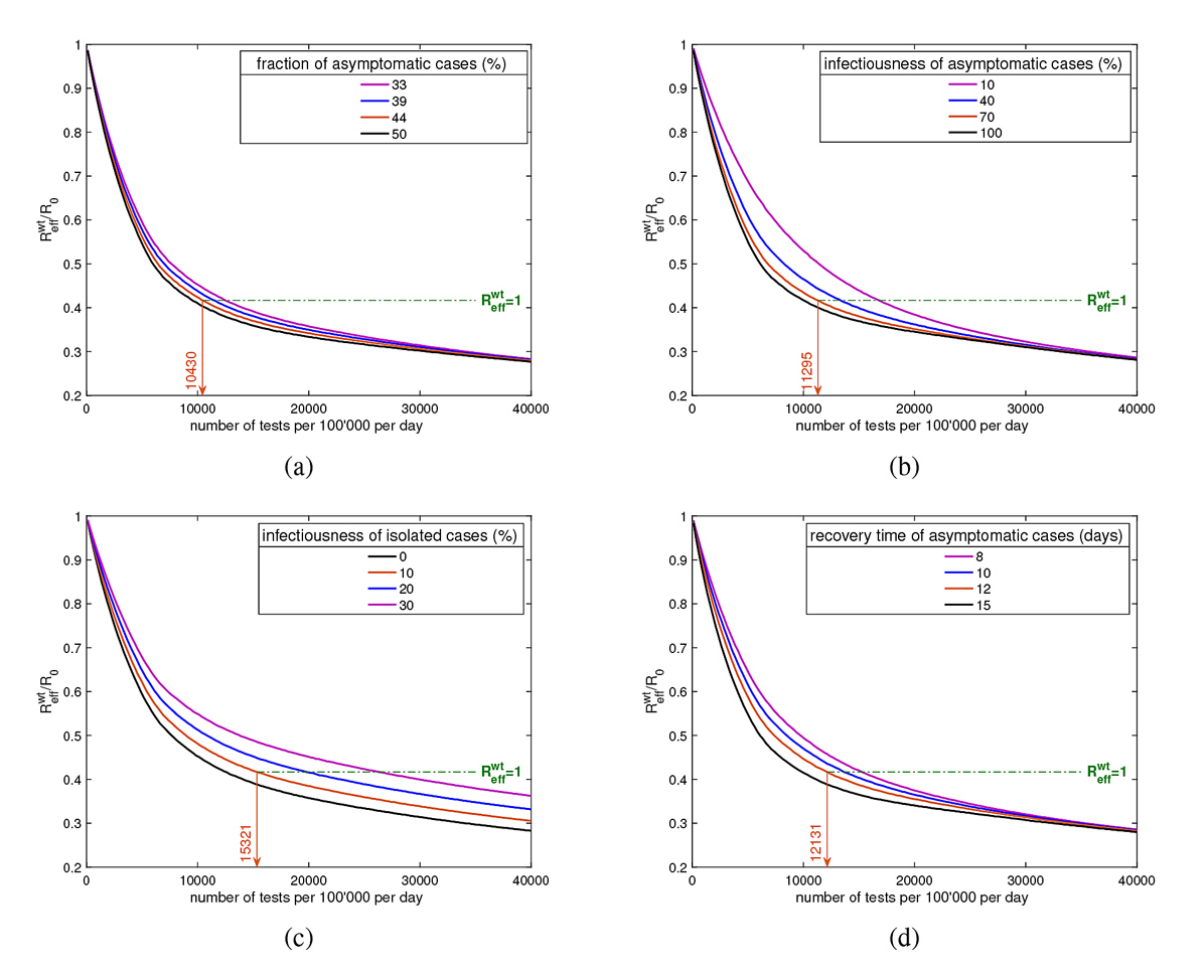
Figure 5: Sensitivity analysis of mass testing with 1 day delay time and a 5% false negative rate. A mitigation strategy relying on mass testing alone is assumed and we computed the number of tests performed per day, which are needed to achieve a particu- ratio; for (a) fraction of asymptomatic cases: 50% (black line), 44% (orange line), 39% (blue line) and 33% (purple lar line); for (b) infectiousness of asymptomatic cases compared to symptomatic ones: 100% (black line), 70% (orange line), 40% effwt ℛ / ℛ 0 (blue line) and 10% (purple line); for (c) infectiousness of isolated cases compared to symptomatic ones: 0% (black line), 10% (orange line), 20% (blue line) and 30% (purple line); for (d) recovery time of asymptomatic cases: 15 days (black line), 12 days (orange line), 10 days (blue line) and 8 days (purple line). The green lines